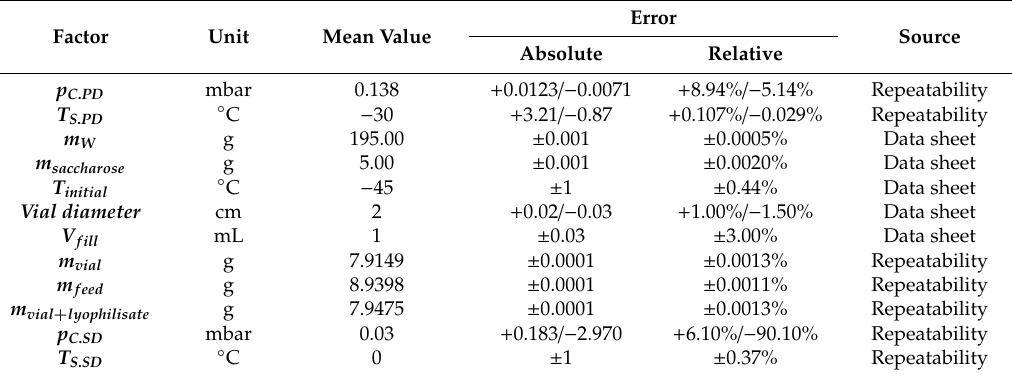
Table 4. Model parameters for Monte Carlo simulation